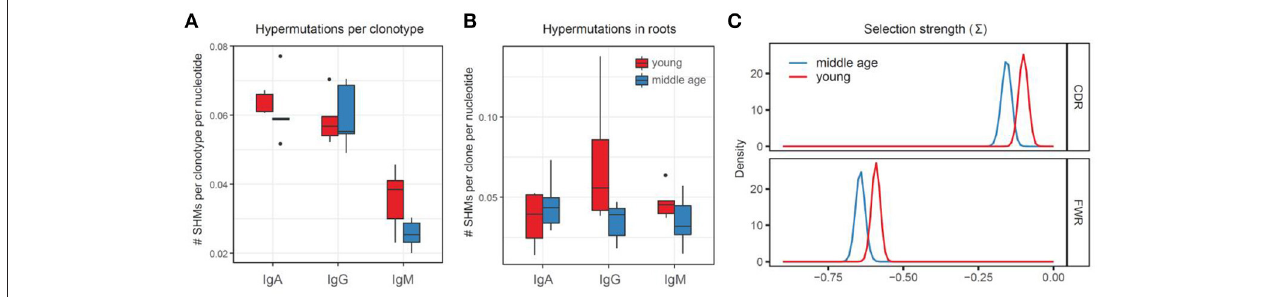
FIGURE 4 | Bulk analysis of somatic hypermutations. (A) Somatic hypermutations per clonotype, without using trees information (NS, ANOVA). (B) Somatic hypermutations within roots of the trees with > 2 nodes (NS, ANOVA). (C) Selection strength estimated using BASELINe framework. Adjusted p = 0.011 for CDR, 0.011 for FWR.